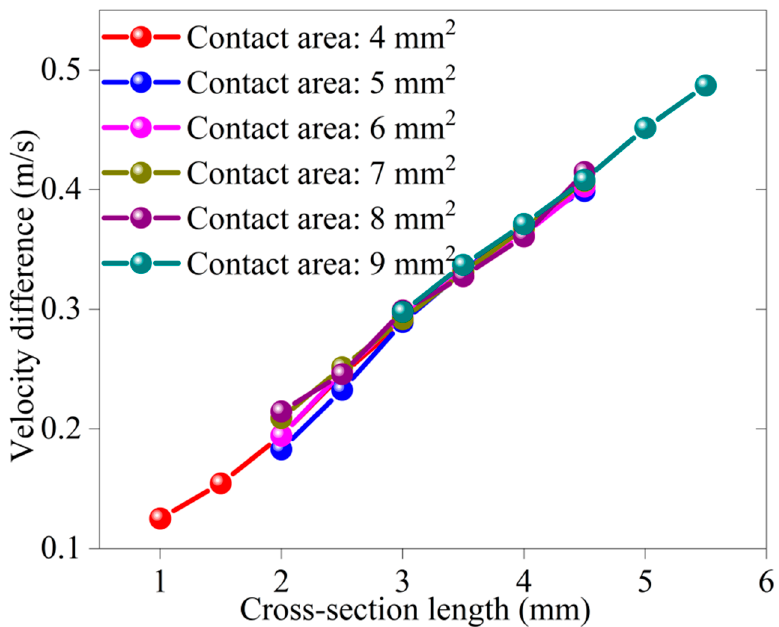
Figure 11. Outlet velocity difference of bifurcated